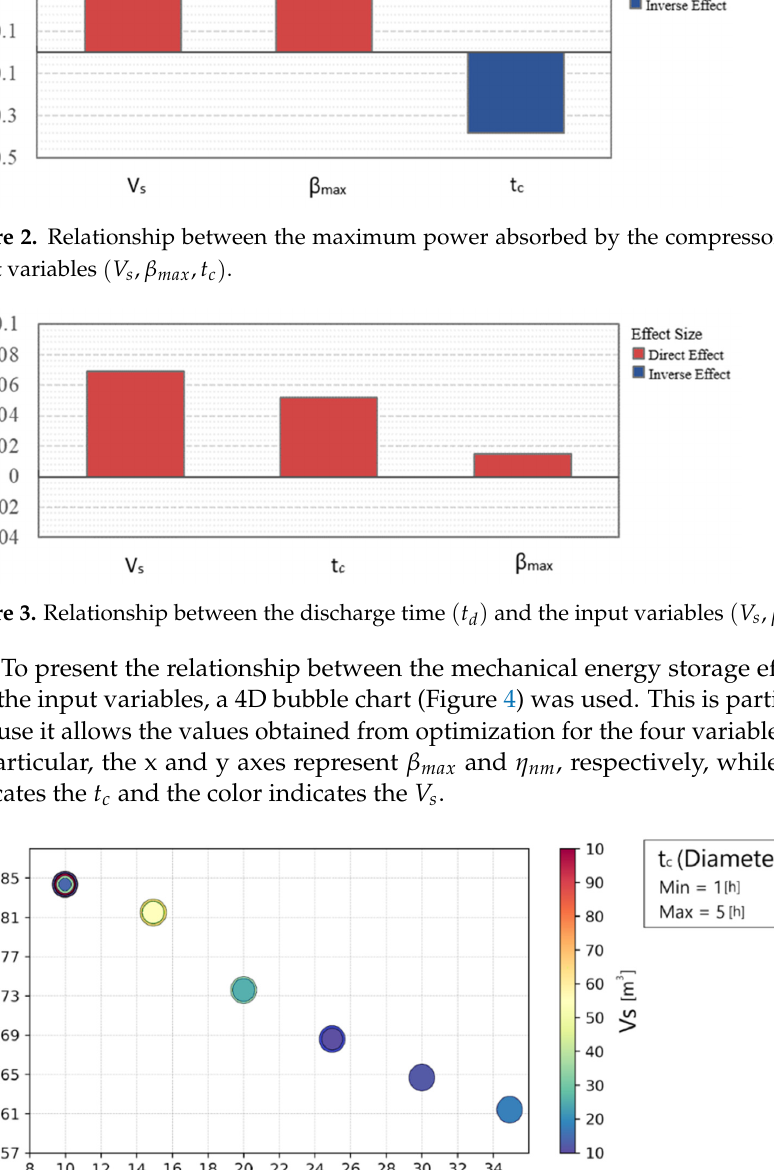
Figure 4. The x and y axes of the 4D bubble chart represent β max and η nm , respectively, while the diameter indicates the t c and the color indicates the V s